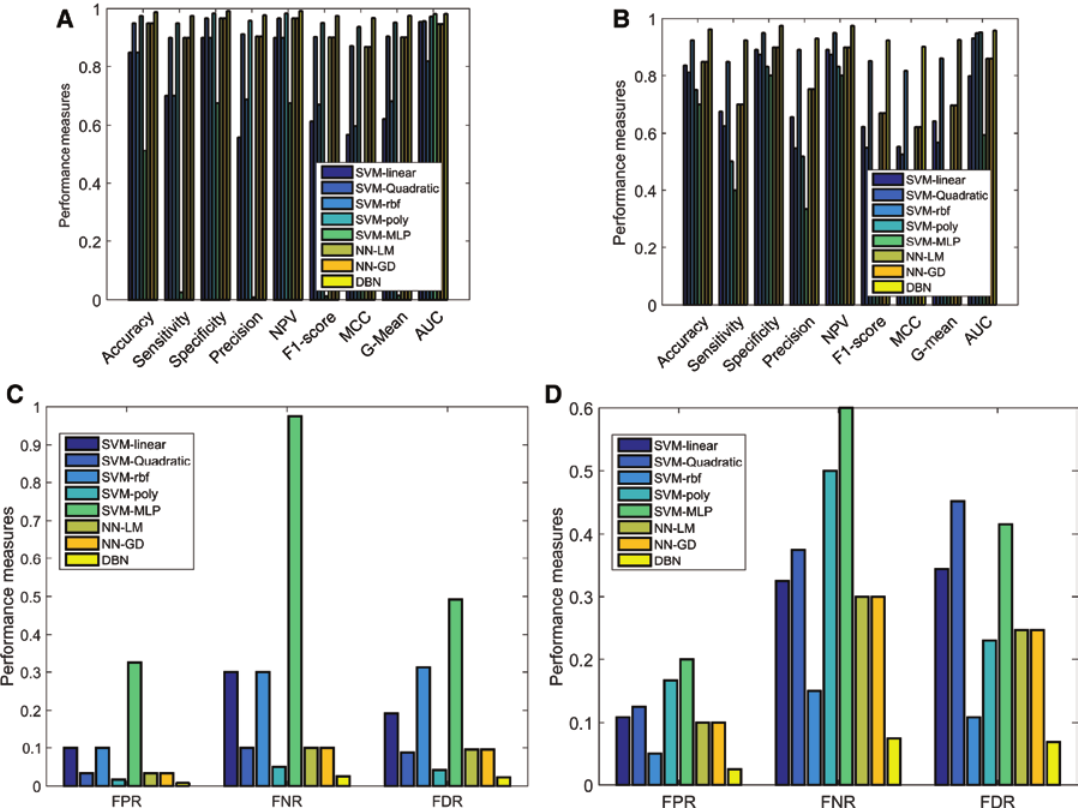
Figure 8: Mean Performance Analysis on Fault Recognition and Classification Including (A) and (B) Type I and Type II Measures at Loading 10 × 10 3 W, Respectively and (C) and (D) Type I and Type II Measures at Loading 20 × 10 3 W,